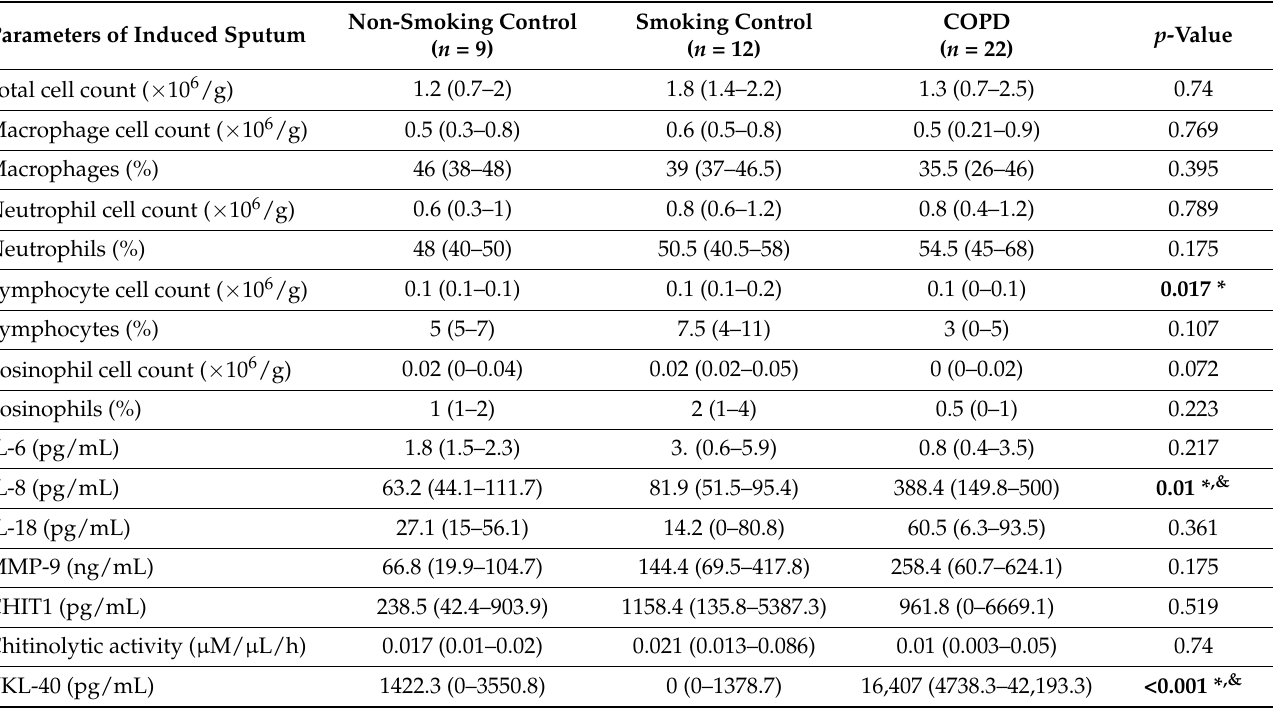
Table 2. Sputum parameters in study participants.